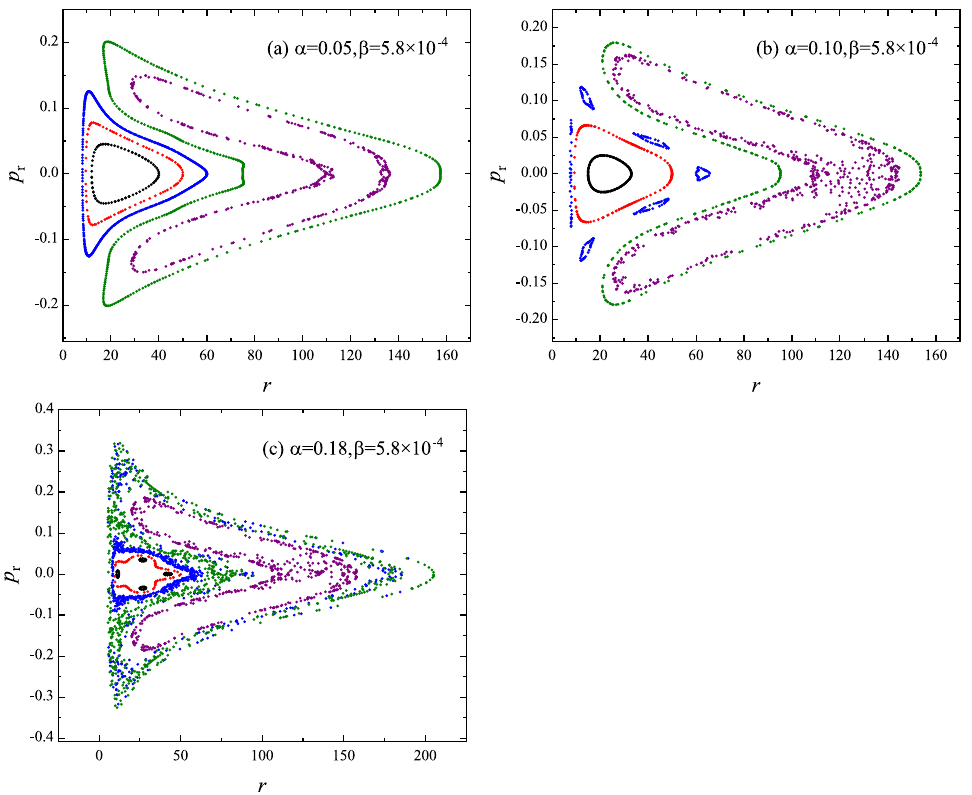
Figure 2. Poincaré sections for three values of the modified gravity coupling parameter, where α = 0.05 in ( a ), α = 0.1 in ( b ) and α = 0.18 in ( c ). The other parameters are E = 0.995, L = 4.6 and β = 5.8 × 10 − 4 . It is shown via the three panels that chaos gets stronger with α